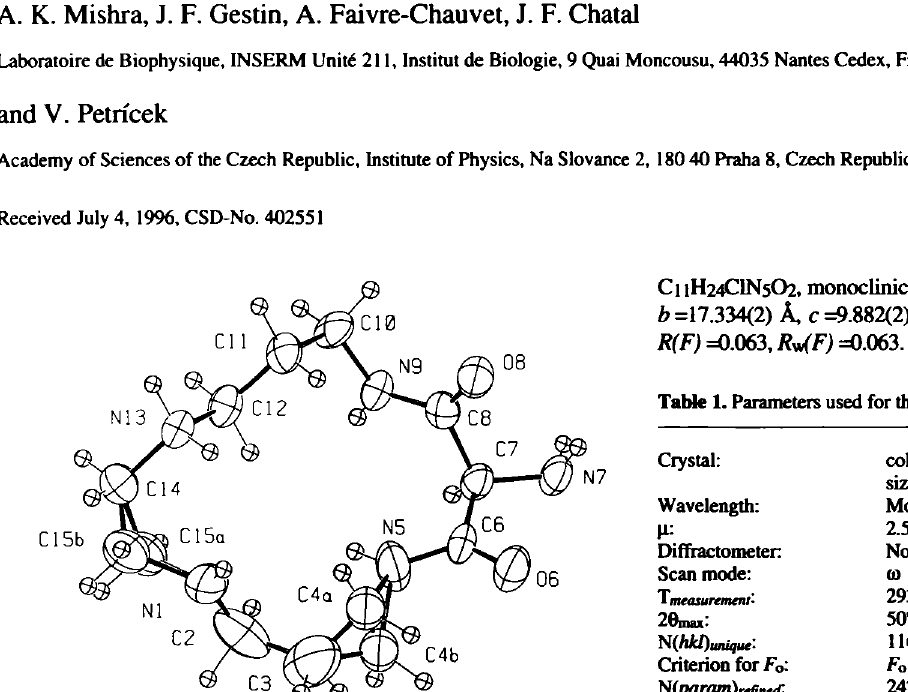
Table 1. Parameters used for the X-ray data collection Crystal: